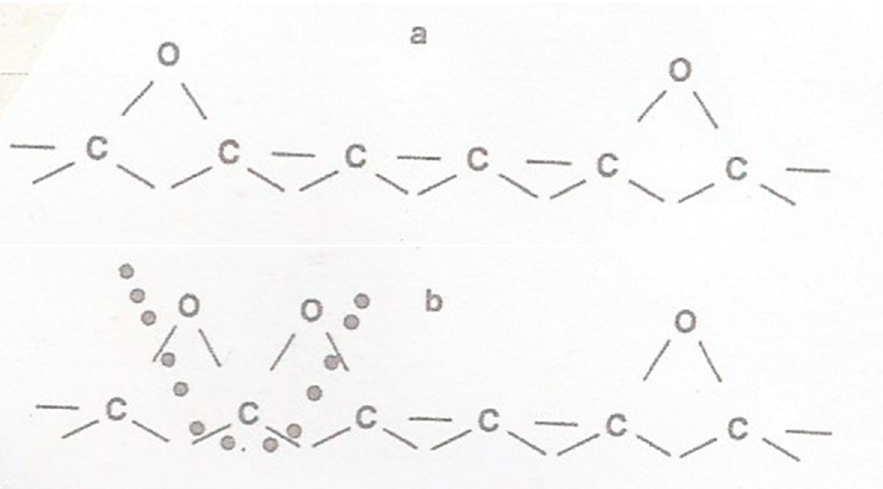
Figure 10. ( a ) Formation of C 2 O. ( b ) Formation of CO 2 .